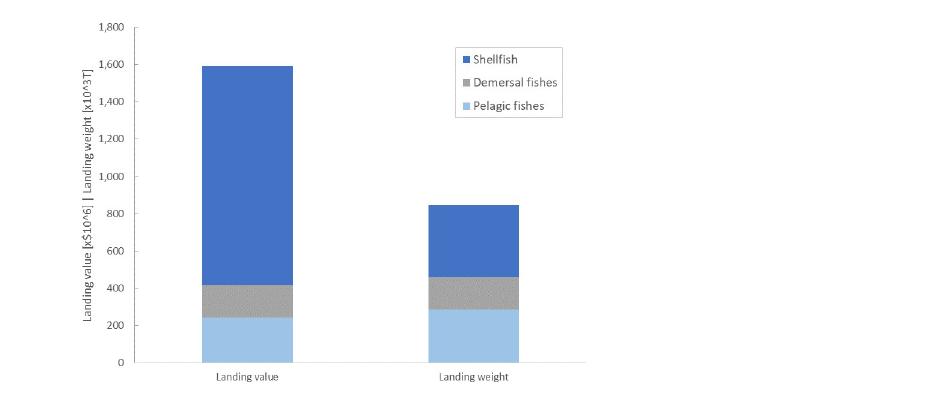
Fig 1. Average annual landings by species groups by dollar value and tonnage. Arranged by species group for Atlantic Canadian fisheries for 1991–2010. Dollar values are normalised to year 2000 dollars and are in millions of dollars, weights are presented in thousands of tonnes (both data types use the same axis). Includes production from aquaculture. Note, in these data ‘shellfish’ encompasses all harvested marine invertebrate species.